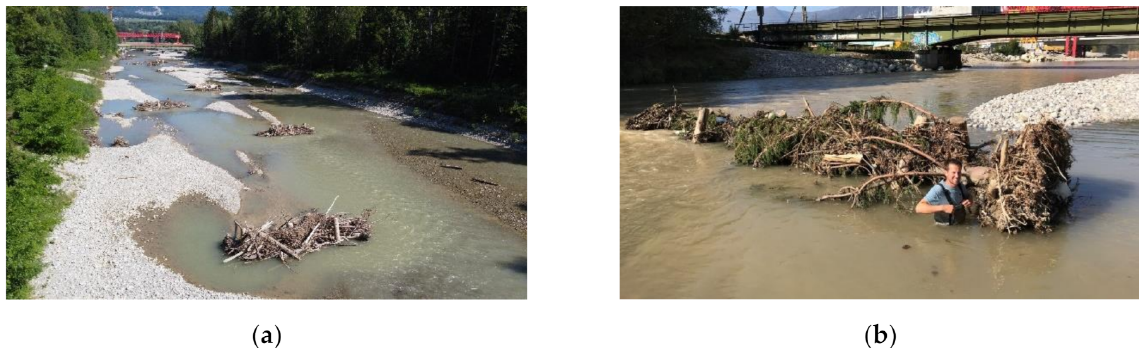
Figure 11. ( a ) Morphological evolution under the influence of LWS approx. 6 months after completion; Emme River; Photo: M. Mende; ( b ) deep pools have formed; Emme River; Photo: M. Mende with G. v. d.